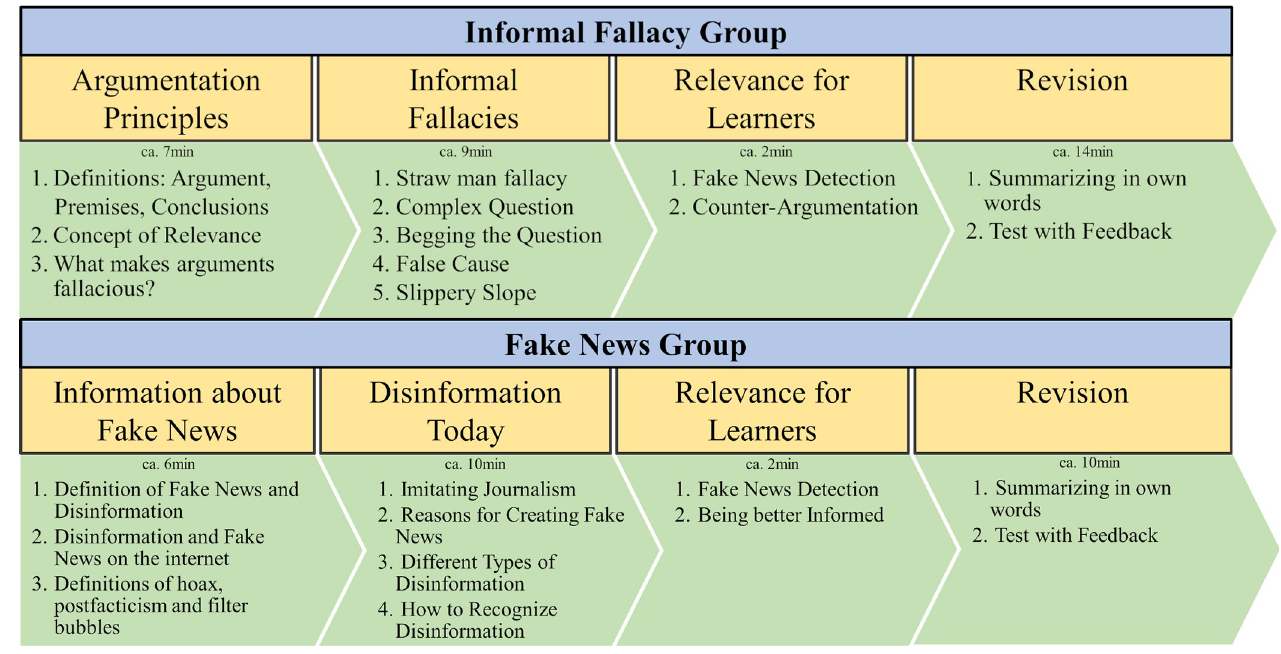
Fig 1. Structure of the two learning interventions. This figure shows the structure of the two learning units including the mean times participants needed to complete a certain part of the unit.